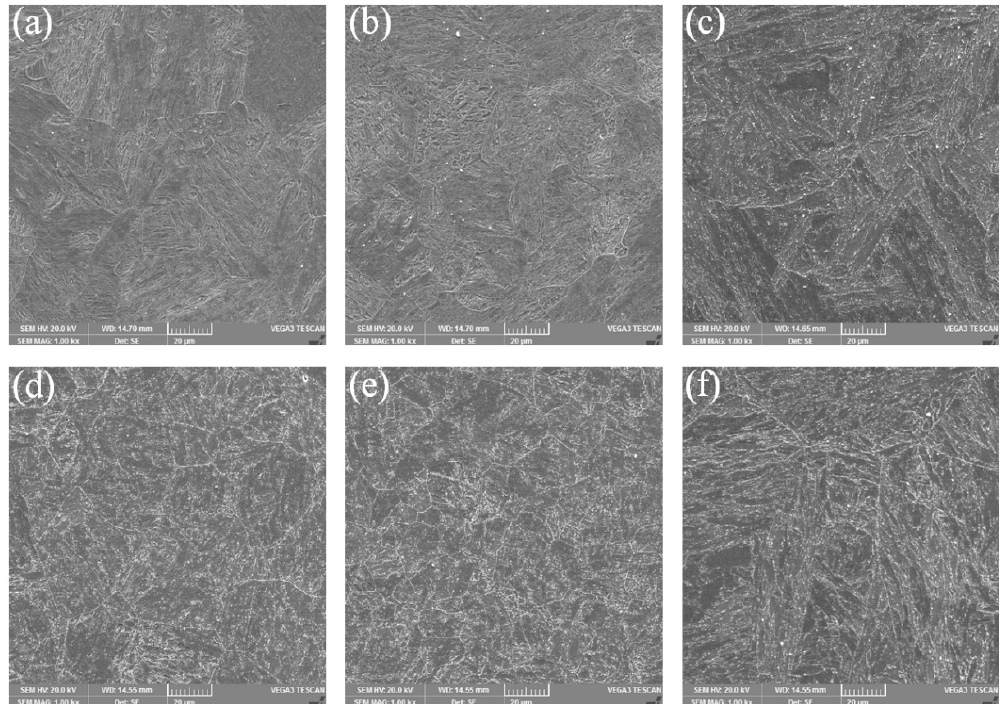
Figure 4. Typical SEM images of HAZ ( a , b ), ( d , e ) and base metal ( c ), ( f ) of G115 steel: ( a )–( c ) without PWHT and ( d )–( f ) with PWHT at 730 °C for 2 h.